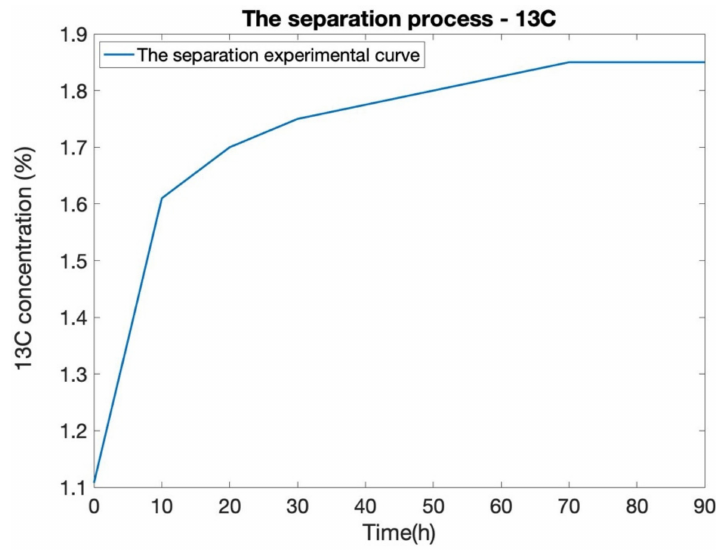
Figure 22. The experimental curve for the 2 M input flow of monoethanolamine in methanol.